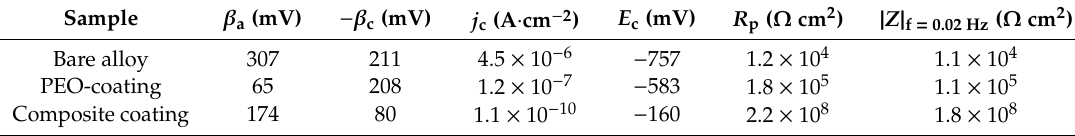
Figure 6. Potentiodynamic polarization curves obtained in 3% NaCl for the bare alloy, PEO and composite coatings. Table 3. Electrochemical parameters of the bare alloy, PEO and composite coatings (Figure